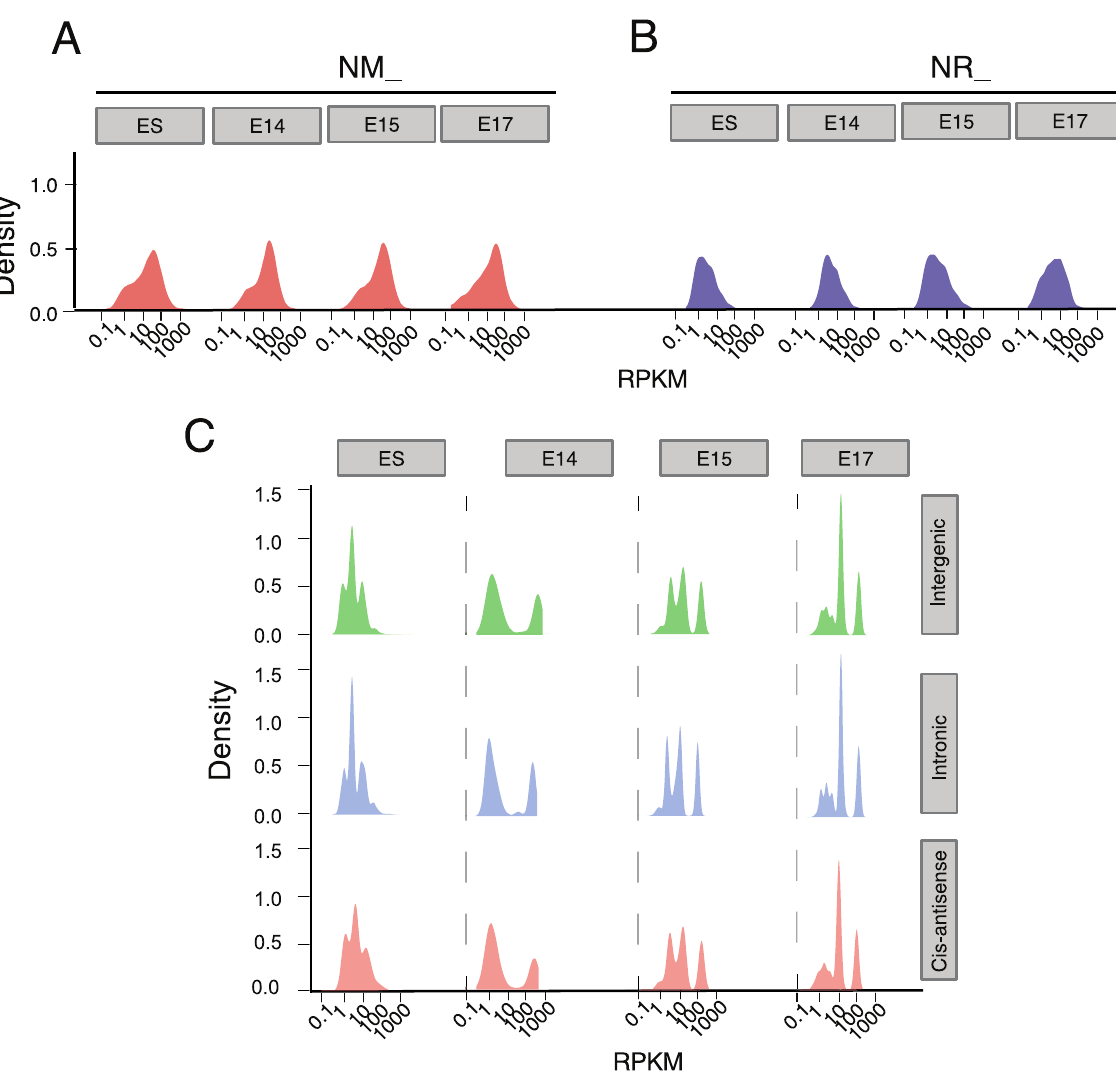
Figure 3. Expression distributions of known long protein-coding, lncRNA genes and putative embryonic brain lncRNA genes. The expression of (A) known long protein-coding (long NM_ RefSeq genes) and (B) known lncRNA genes (long NR_ RefSeq genes) and (C) putative embryonic brain lncRNAs over ES cell and developmental brain are compared. Consistent with previous studies, the expression of known long protein-coding RefSeq genes is significantly higher than known lncRNAs. The novel lncRNAs we identified are expressed at comparable levels with known NR_ transcripts. Notably, putative embryonic brain lncRNAs are expressed at about one tenth on average compared to known long protein- coding genes. Intergenic, intergenic lncRNAs; Intronic, intronic lncRNAs; Cis-antisense, cis-antisense lncRNAs. The gene expression (X-axis) is measured by RPKM which is a normalized metric for comparing gene expression of different genes.